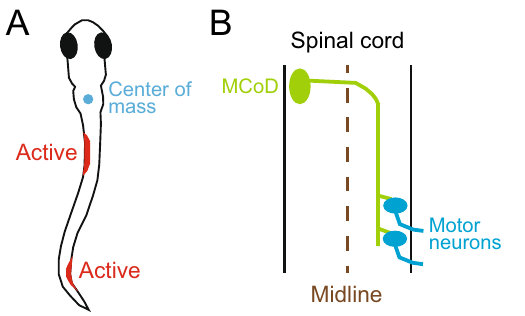
Figure 1. Swim form of a zebrafish larva and projection of an MCoD neuron. ( A ) One of the swim forms of a zebrafish larva at 4 to 5 dpf. The cyan circle shows the center of mass, which is located near the swim bladder. Muscle contractions are presumed to occur in the two locations marked in red. ( B ) Projection pattern of an MCoD neuron in the spinal cord. The axon of the MCoD neuron crosses the midline (broken line), descends on the contralateral spinal cord, and makes mono-synaptic excitatory connections onto caudally located